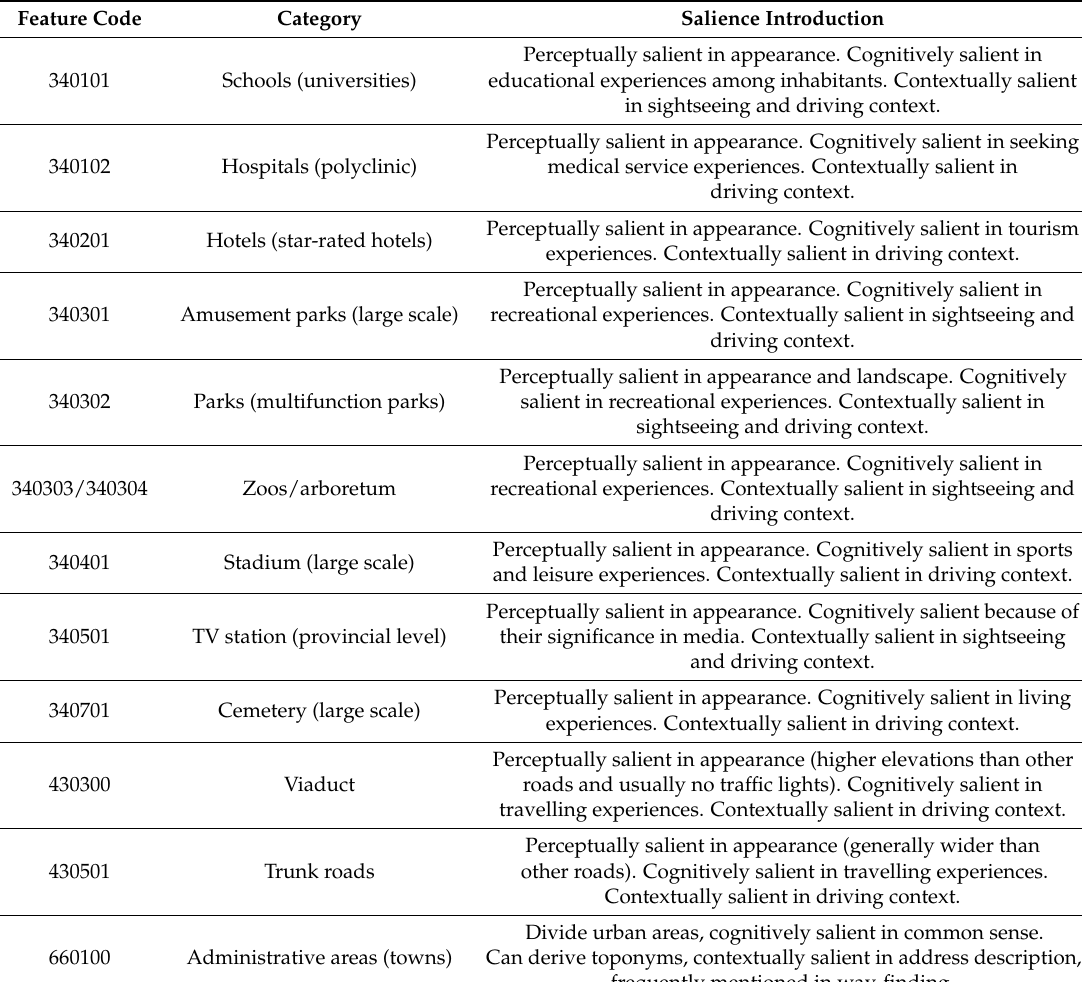
Table 2. Categories of Landmarks at Medium